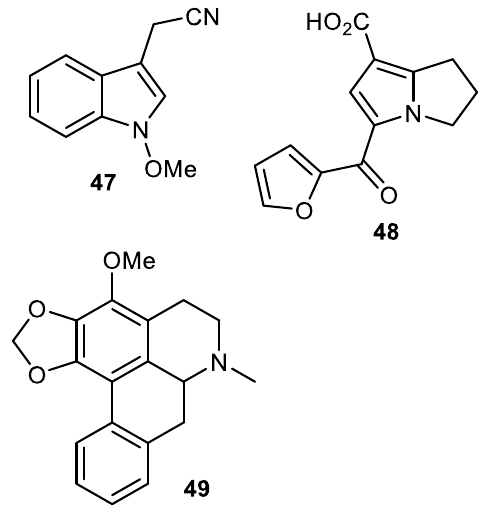
Figure 7. Structures of alkaloids 47 – 49 .